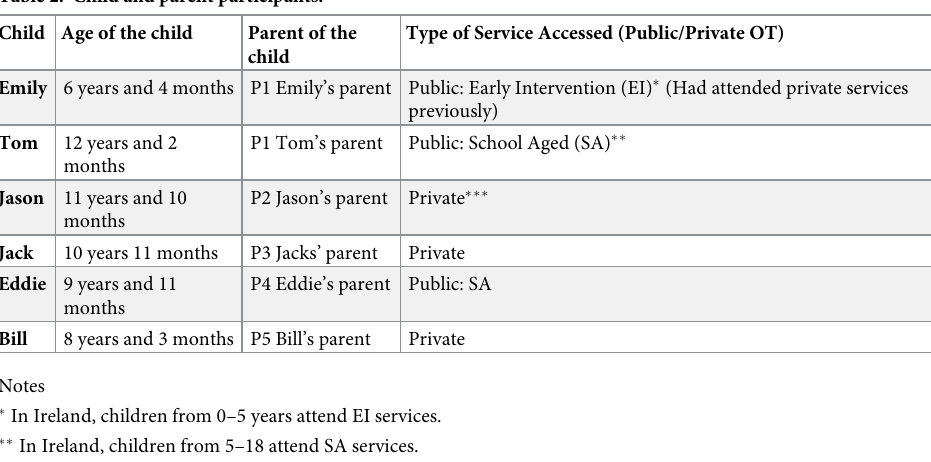
Table 2. Child and parent